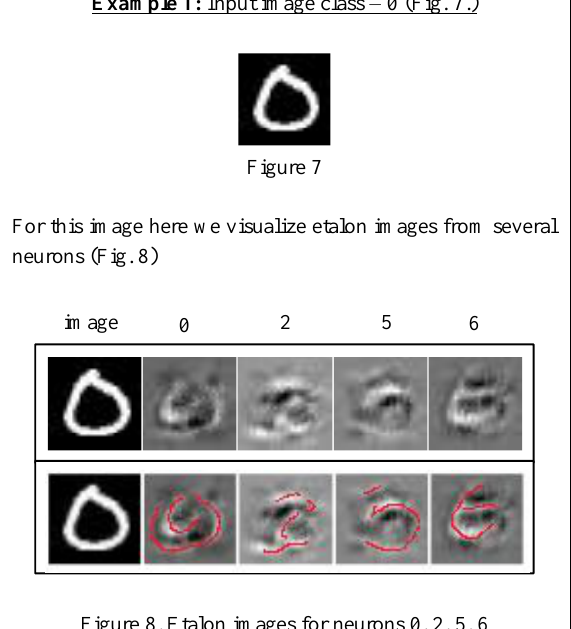
Figure 8. Etalon images for neurons 0, 2, 5,